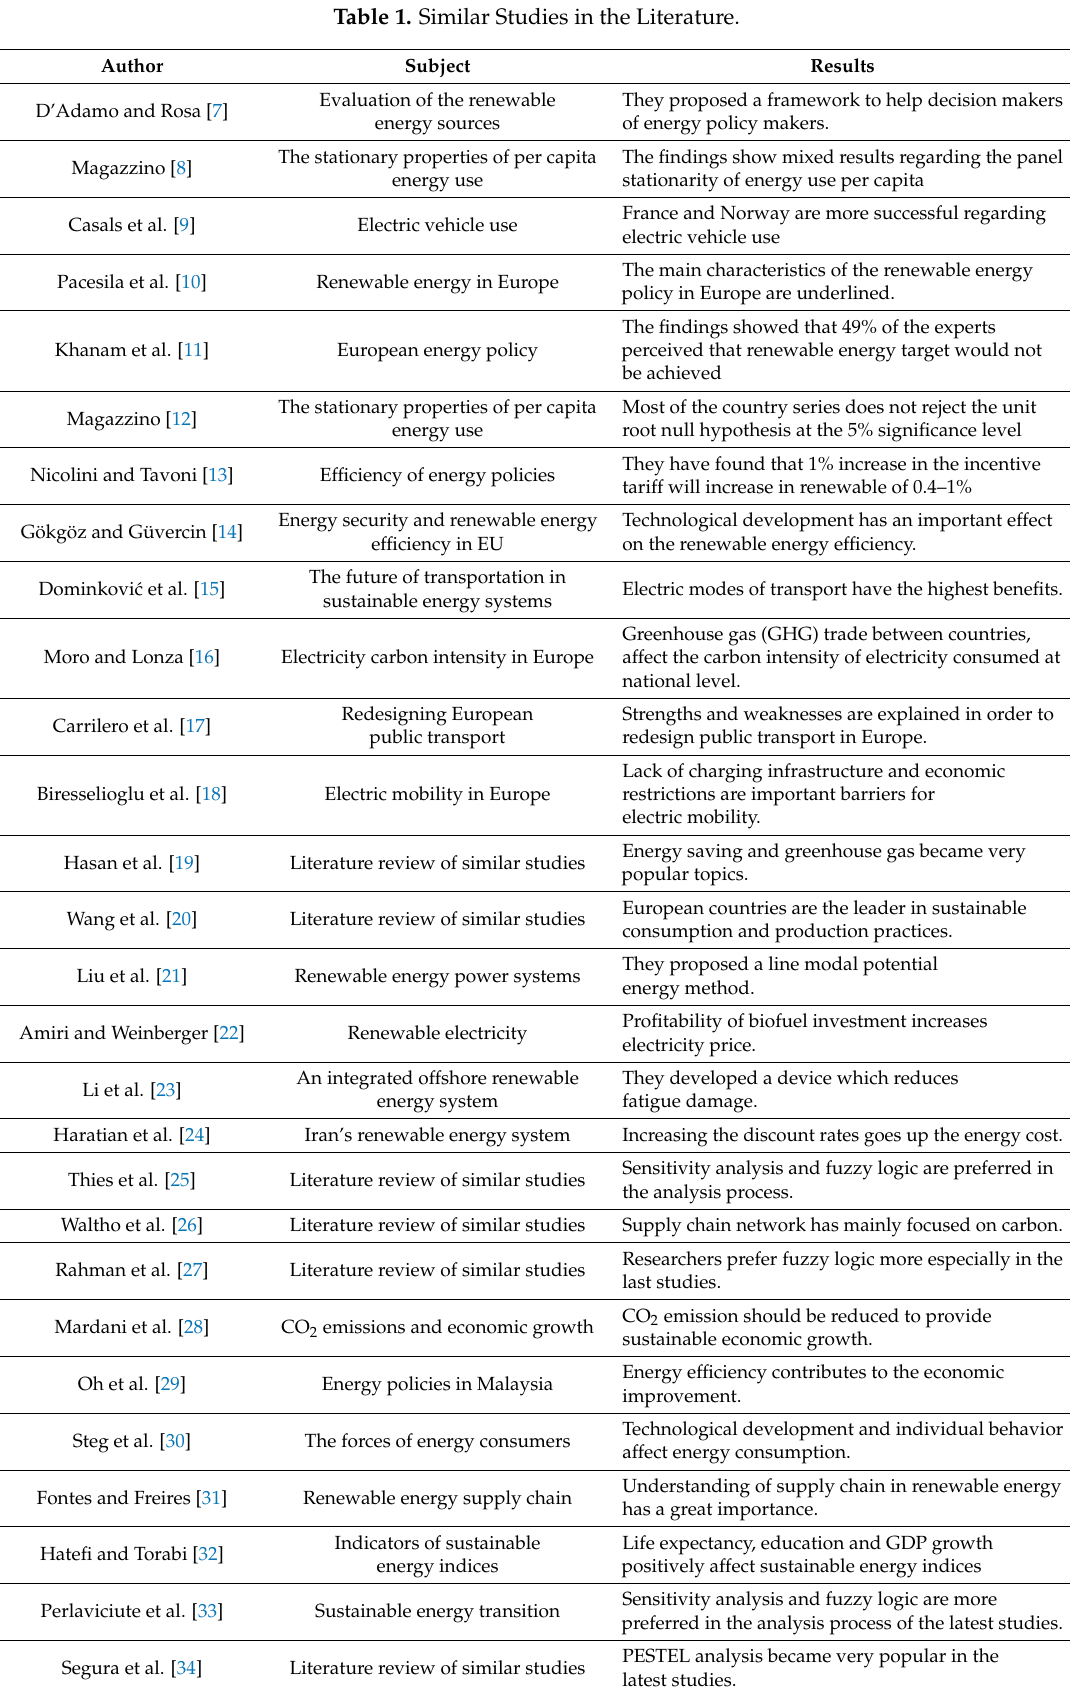
Table 1. Similar Studies in the